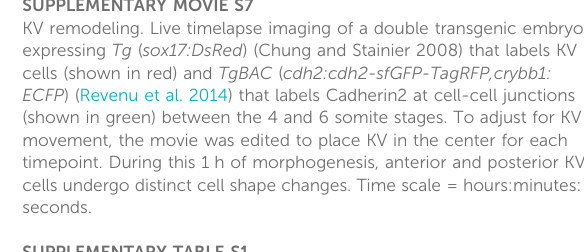
SUPPLEMENTARY TABLE S1 Useful molecular markers to visualize LR asymmetries in the zebra fi sh embryo using RNA in situ